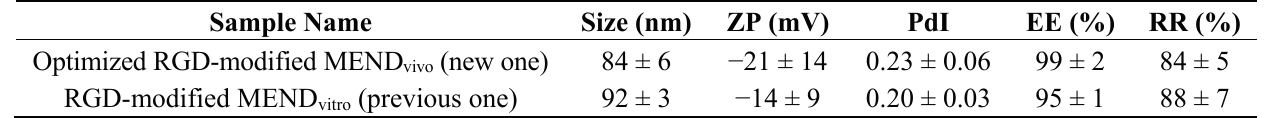
Table 2. Characterization of the MENDs used in the in vivo